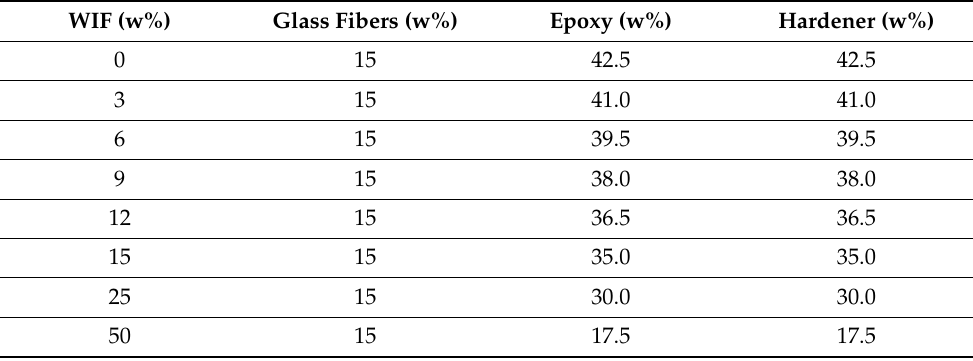
Table 1. The fabrication conditions of the WIF-reinforced GFRE